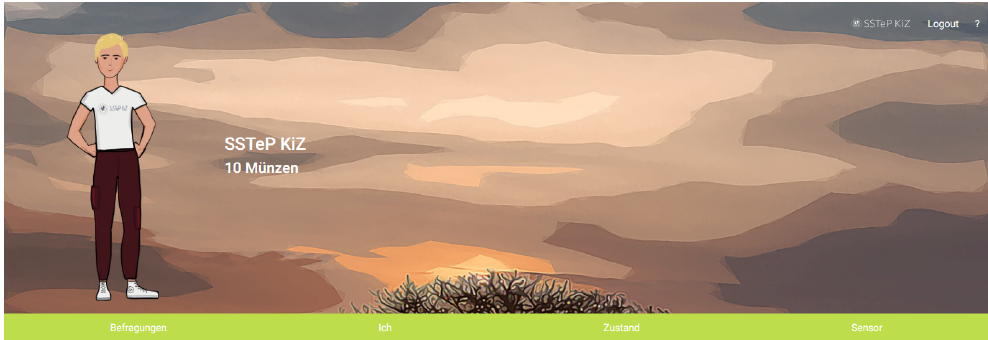
Figure 20. Patient Portal: screenshot of avatar with its clothes and accessories in South